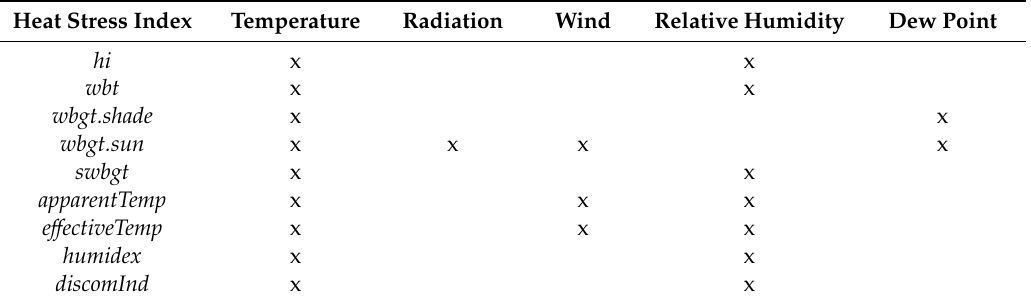
Table 1. Employed heat stress indices with respective input parameters.